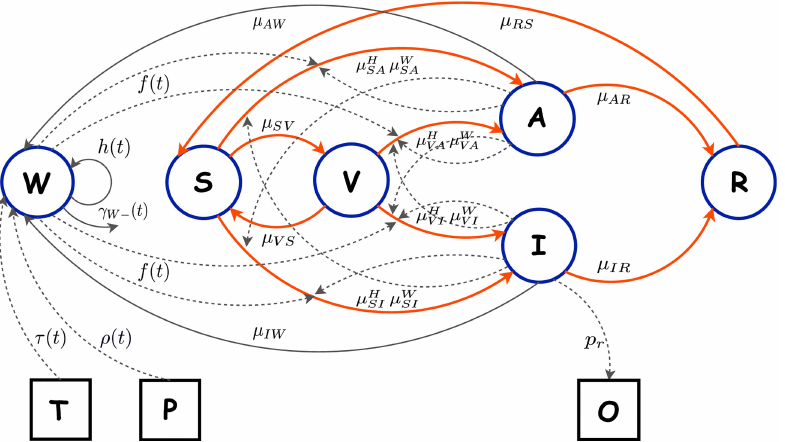
Fig 1. The complete diagram of the compartment model with vaccination intervention is presented. The unobservedhumancompartments and environmental compartment W of the SIRS model are denotedby circles whilethe observed data are representedby squareboxes. Humans move through the unobserved SIRS compartmentsand interact with the unobserved environmental reservoir W which is influencedby the ambienttemperature T and precipitation P . The unobserved number of asymptomatic A and symptomatic I cholera infectionsare linkedto the observedincidence O . Solid lines denote either the movement of humans betweencompartments (thick orangelines) or the bacteria shedding and multiplication in the environment (thin grey lines). Dashedlines represent the relationshipsbetweendifferent elementsof the dynamic model that are incorporated via the system of model equations.Susceptibleindividuals S move to the vaccinated compartment V for the durationof immunity providedby the vaccine; where vaccinated individualscan become infected based on the efficacy of the